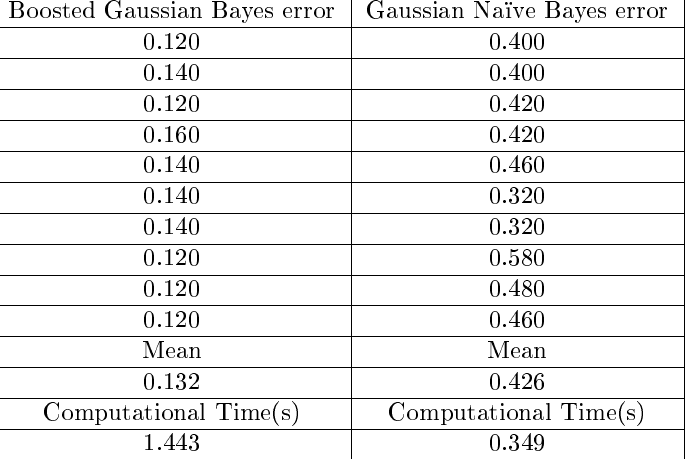
Table 4. Comparison result of two